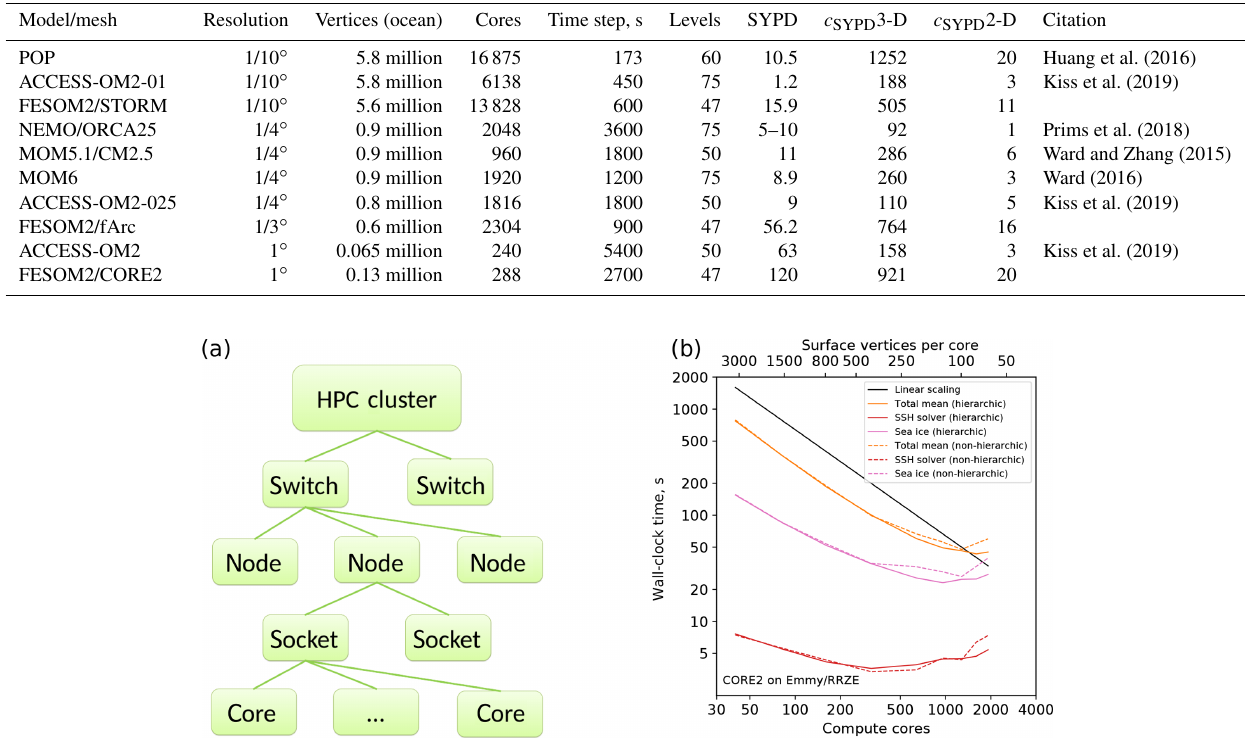
Table 3. Throughput of different models at selected configurations comparable to FESOM2 STORM, fArc and CORE2 meshes. Vertices are 2-D degrees of freedom only in the ocean. It is not possible to express the resolution of FESOM2 configurations in a single number, therefore we list resolutions that regular Mercator grid would have with a similar number of ocean degrees of freedom. Data for FESOM2 configurations are taken from 1-year simulations with I/O.